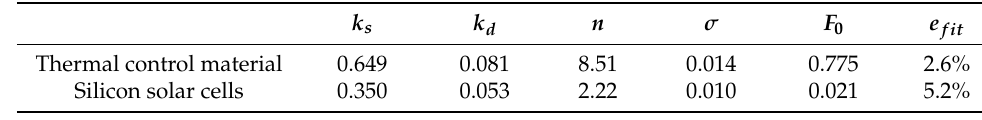
Table 1. Fitting results of BRDF model parameters at 850 nm.